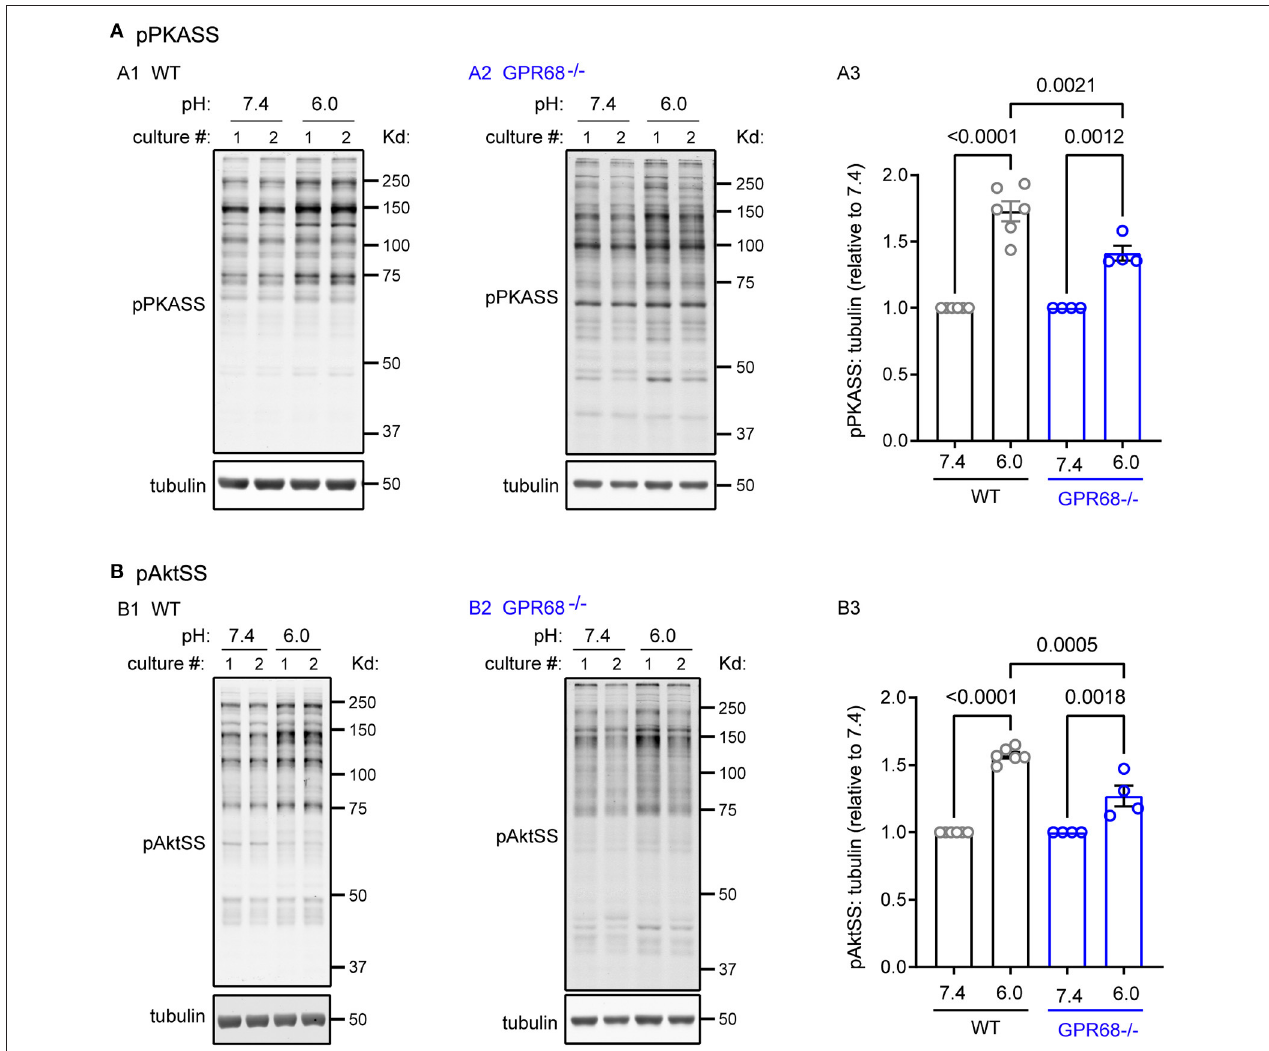
FIGURE 5 | Acidosis increases the phosphorylation of PKA and Akt substrates. Representative Western blot and quantification of 1-h pH 6-induced phosphorylation of (A) PKA substrates (pPKASS) and (B) Akt substrates (pAktSS) in WT and GPR68 − / − hippocampal slices. Blots and images were representative from 4 to 6 different cultures/pups (see Methods or Figure 2 Legends for additional clarification). P -values were from 2-way ANOVA with Tukey’s